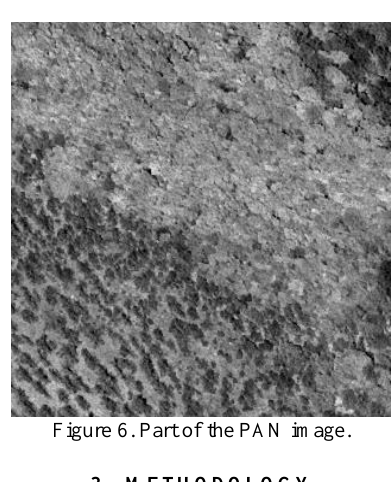
Figure 6. Part of the PAN